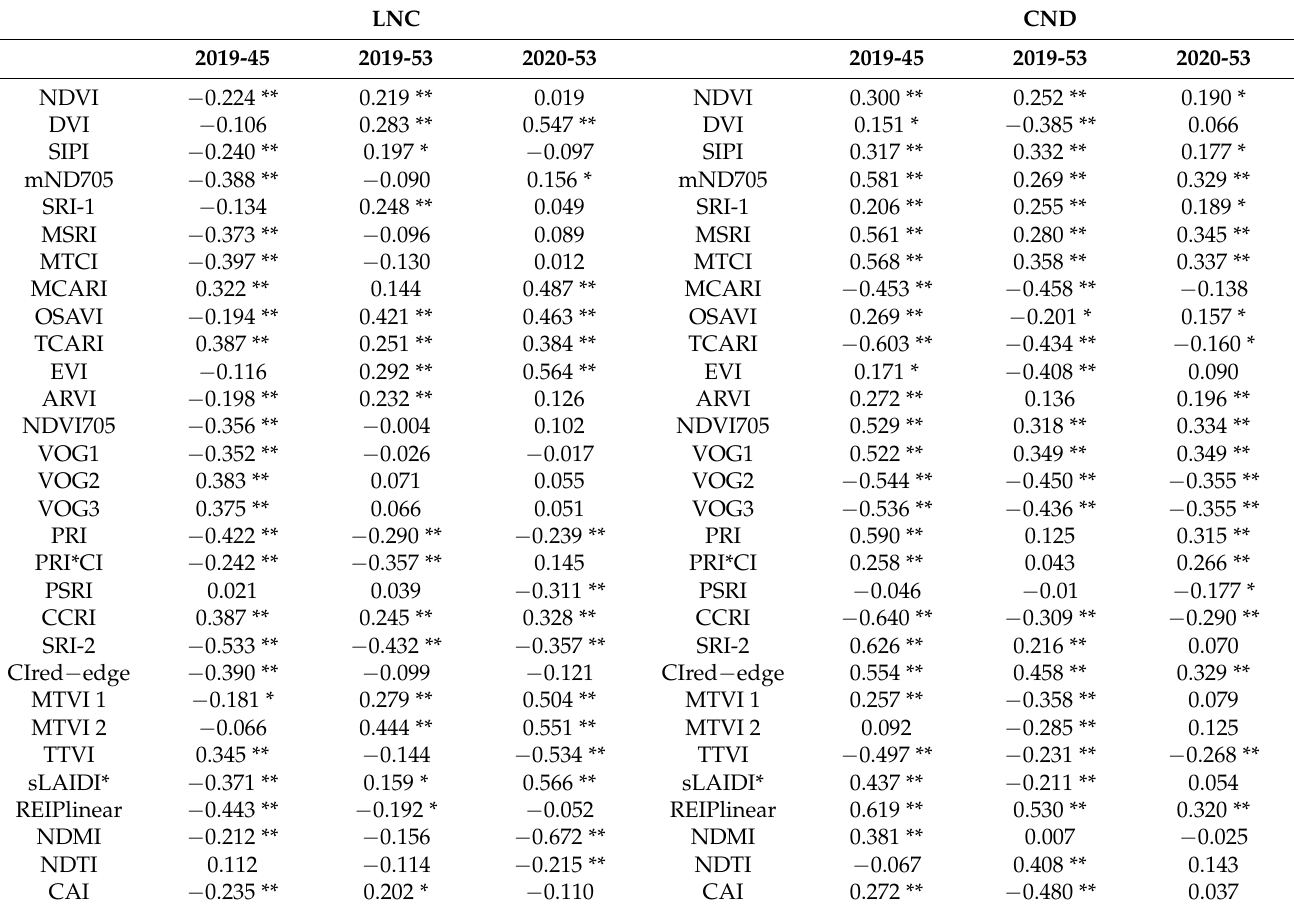
Table 6. Correlation analysis between LNC, CND, and spectral index of cotton in different